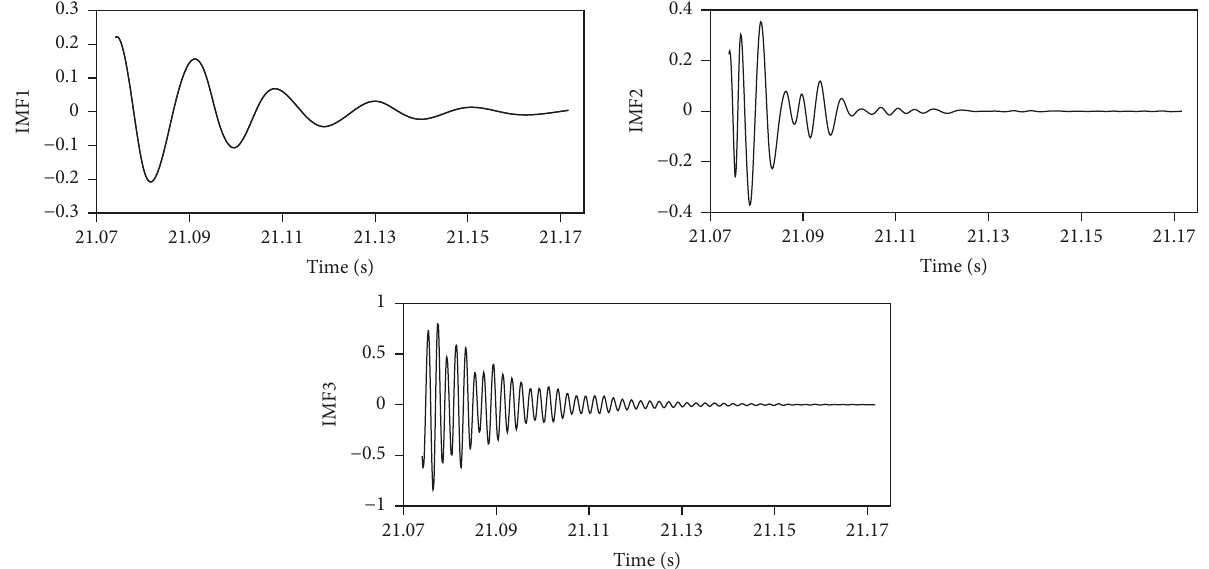
Figure 13: The lowest three IMFs on 18 September 2016 at 8:00 am.